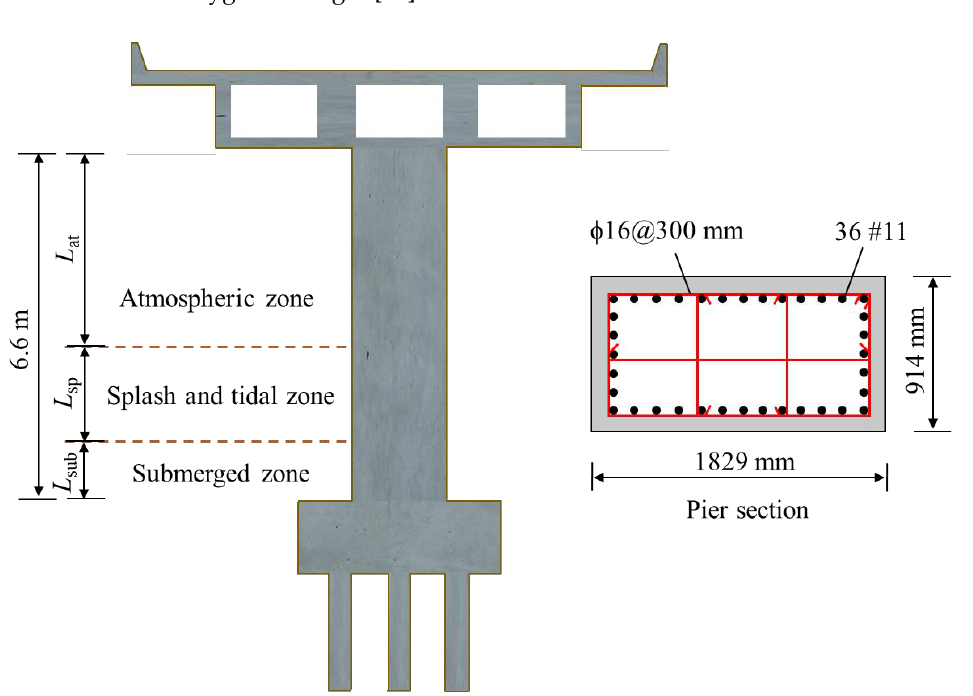
Figure 6. Schematic diagram of the coastal bridge pier. Table 1. Random variables for the reliability analysis of the coastal bridge